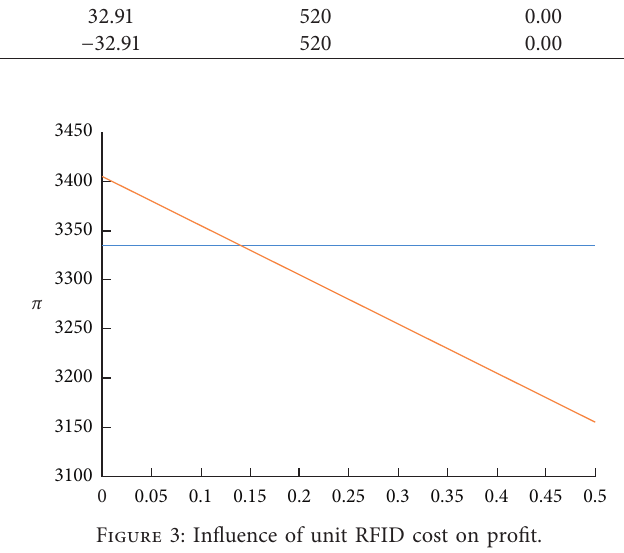
Figure 3: Influence of unit RFID cost on profit.